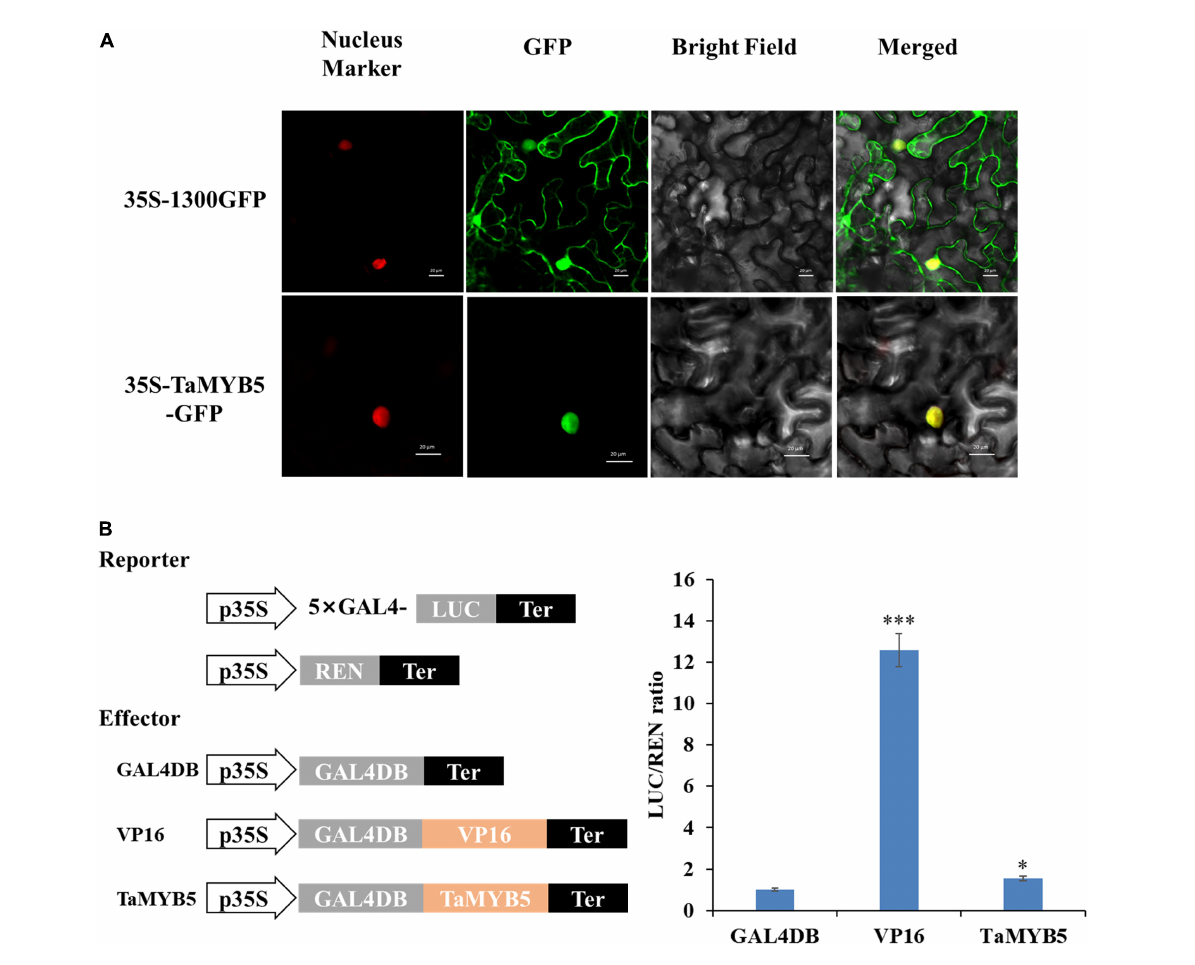
FIGURE7 Subcellular localization and transcriptional activity analysis of TaMYB5. (A) 35S-TaMYB5-GFP and the nuclear localization marker (mCherry) were transiently co-transformed into tobacco leaf cells. Scale bar = 20 µ m. (B) Transcriptional activity of TaMYB5. The LUC/REN ratio of TaMYB5. Data are means of three independent experiments. * P < 0.05, *** P < 0.001. Error bar, ± SE.